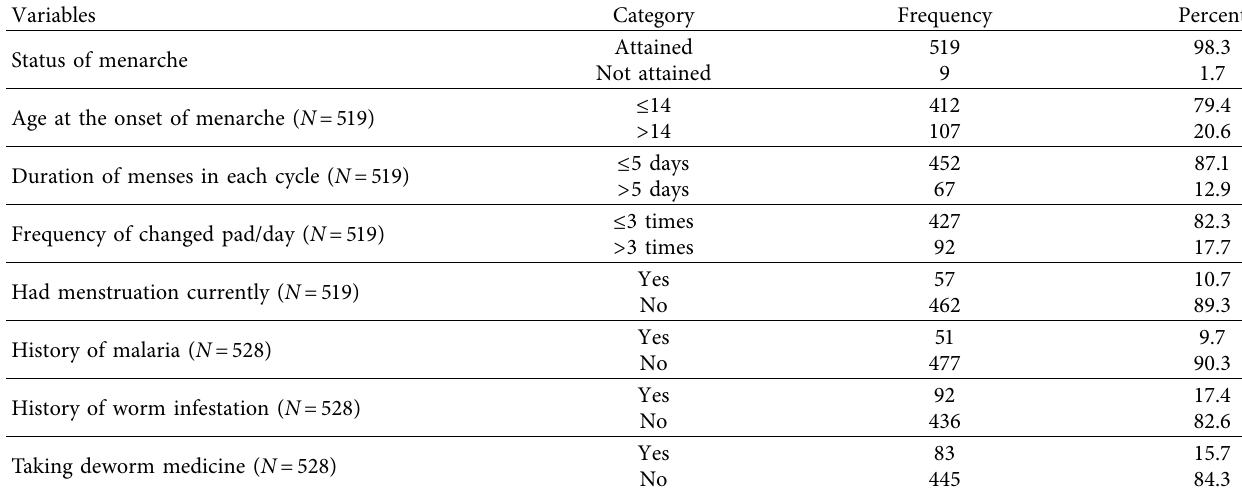
Figure 3: Distribution of DDS among secondary school adolescent girls in Jimma town, southwest Ethiopia. Table 2: Health-related characteristics of the study participants among adolescent high school girls in Jimma town, Oromia, southwest Ethiopia.